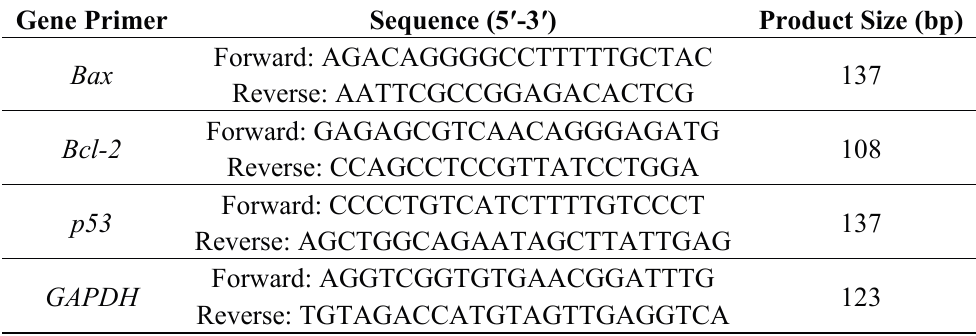
Table 4. Primer sequences of apoptosis-related genes used in this